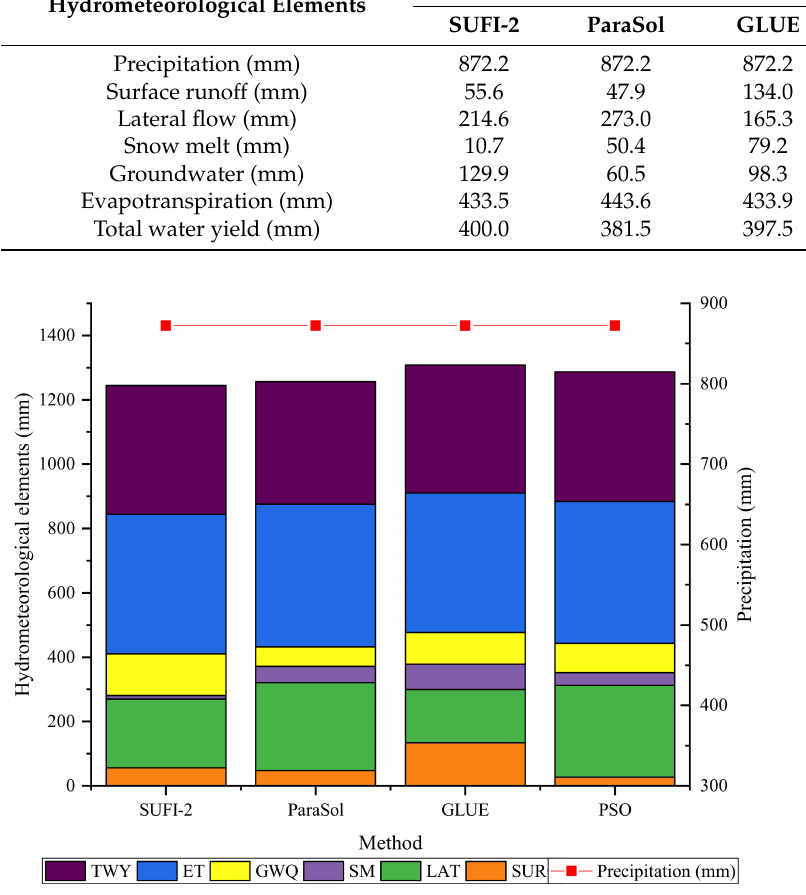
Figure 7. Multi-year average variation in different hydrological components derived from the SUFI-2, ParaSol, GLUE, and PSO methods from 1975 to 2004. (Notation: TWY = Total Water Yield, ET = evapotranspiration, GWQ = Groundwater Runoff, SM = Snow Melt, LAT = Lateral Runoff, SURQ = Surface